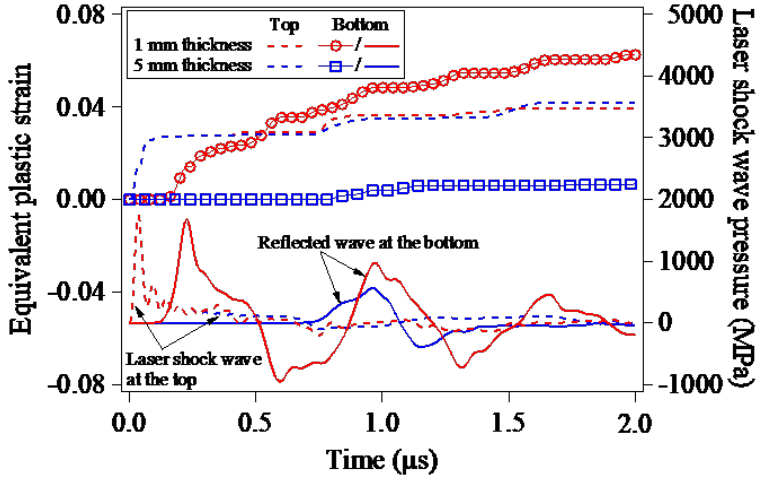
Figure 11. Evolutions of the equivalent plastic strains and the LSP − induced shock waves at the top and bottom surfaces of the target during the LSP process.